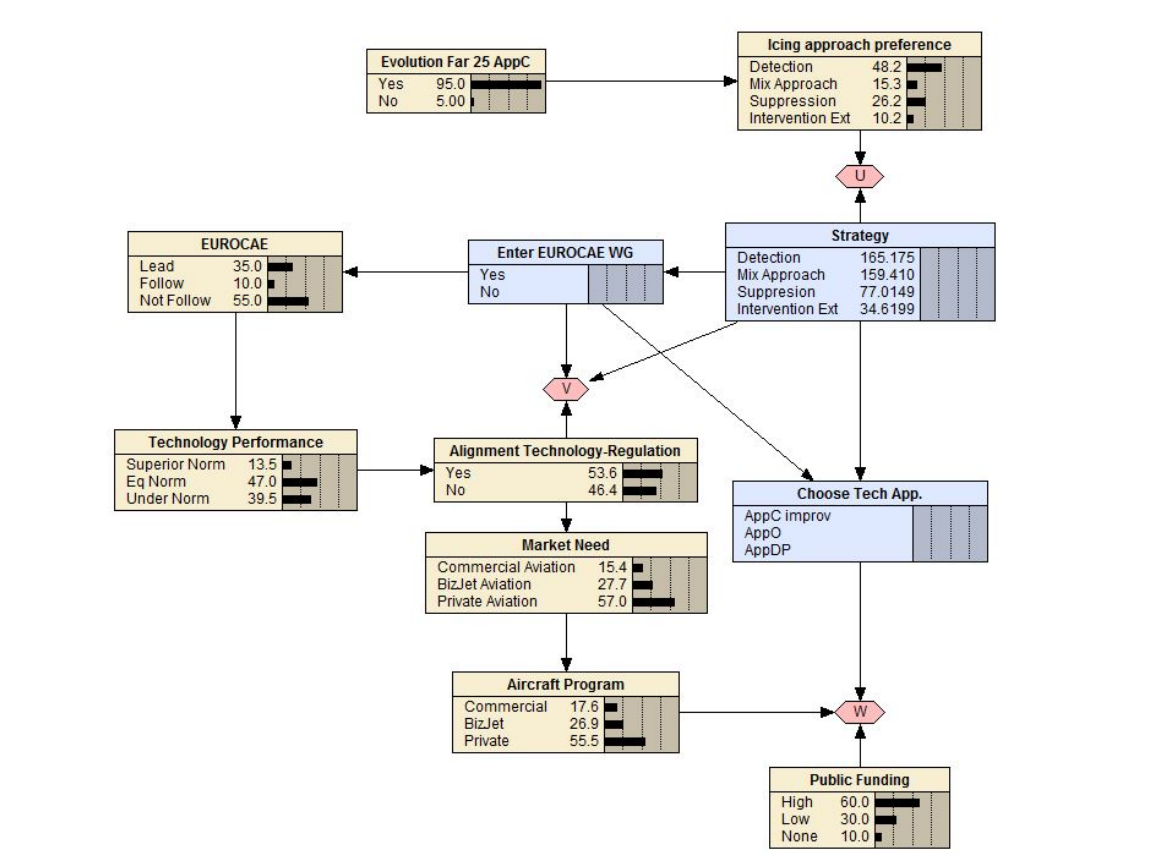
Fig. 3. Second decisional space: Expanded and reconfigured decisional space following an irrational